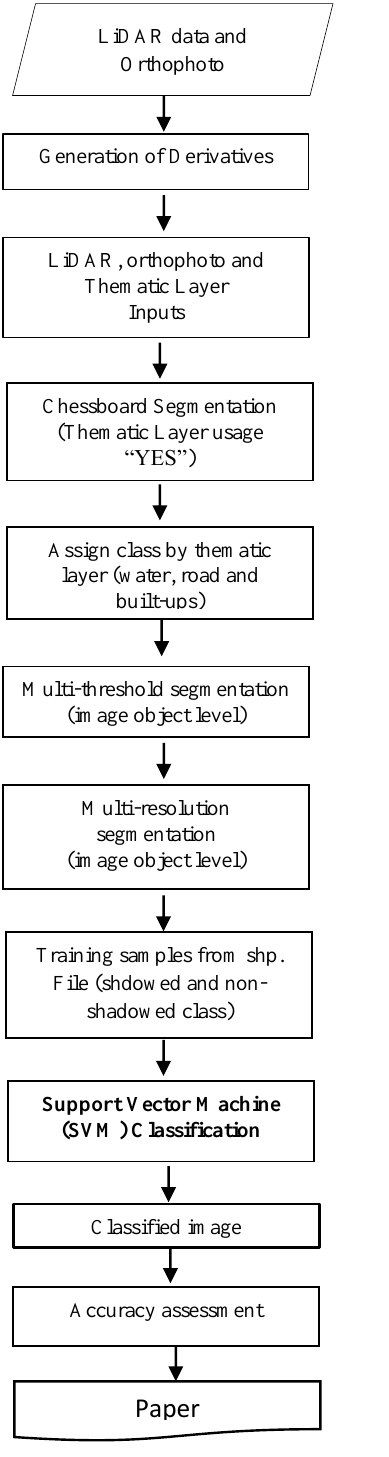
Figure 4. Flow chart of the current methodology.